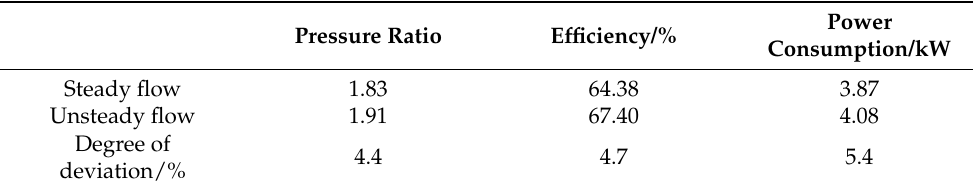
Table 5. Comparison of the unsteady flow energy of the original compressor at the joint point with the steady flow value at 150,000